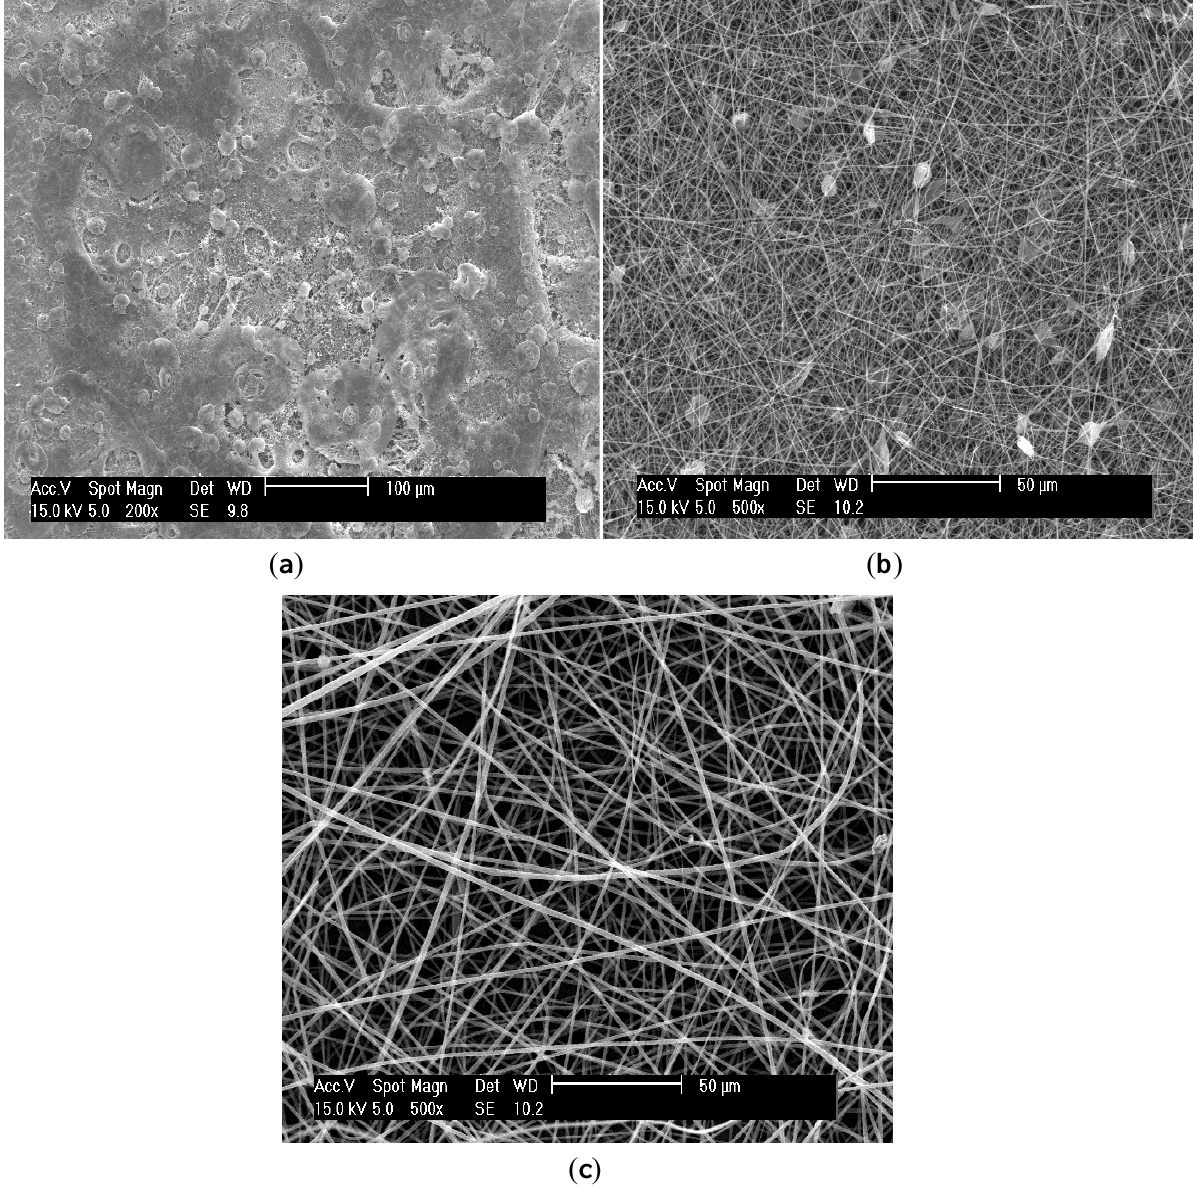
Figure 2. SEM micrographs of electrospun polymer fibres obtained when electrospinning from ( a ) 2 wt%; ( b ) 5 wt%; and ( c ) 8 wt% polymer solutions at 20 kV and NCTD of 12.5 cm,